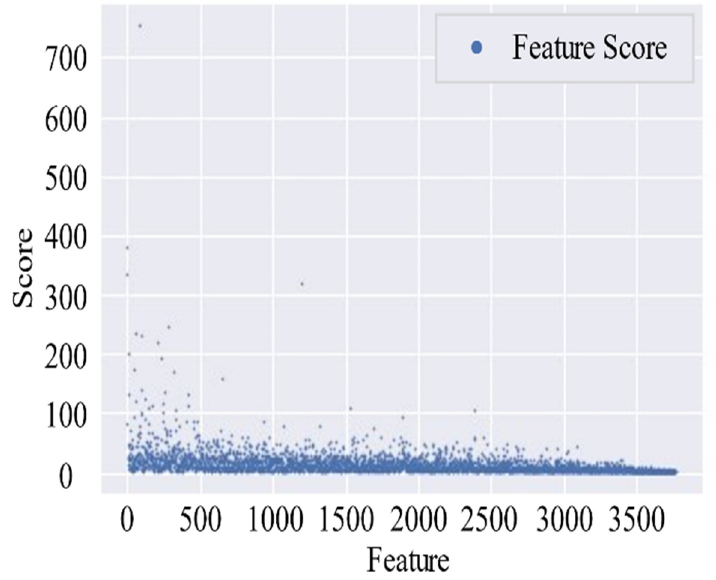
Figure 26. Features and their importance score on dataset M. Table 12. XGBoost2 trained by different features.